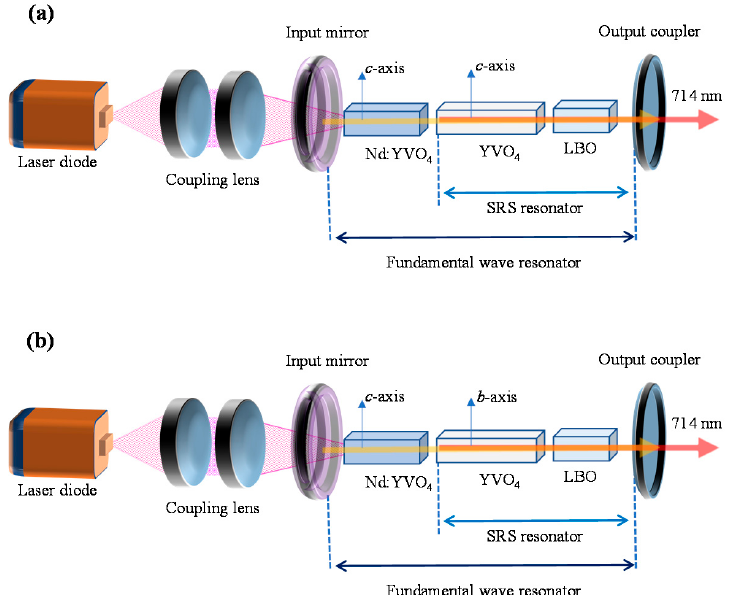
Figure 1. Experimental setup for a diode-pumped Nd:YVO 4 /YVO 4 Raman laser to achieve a high- power 714 nm laser at the CW operation. Both c -axes ( a ) parallel ( b ) perpendicular to each